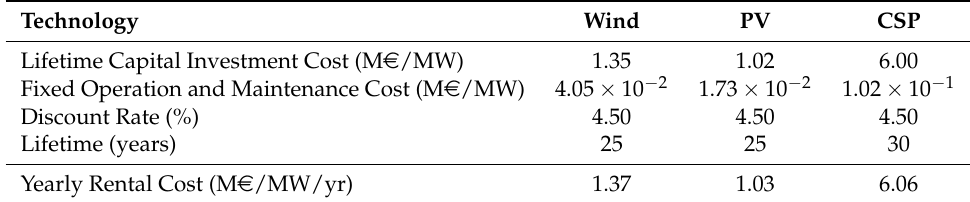
Table 3. Capital investment, fixed operation and maintenance costs, lifetime are from the European Commission Joint Research Center (JRC) technical report [52] for the year 2015 (see Tables 12 and 10 for PV, Tables 2 and 5 for wind and Tables 15 and 16 for CSP), the discount rate is from the Design and Sustainability of Renewable Energy Incentives: An Economic Analysis Report ([59], p. 27) and the yearly rental cost per technology calculated using Equation